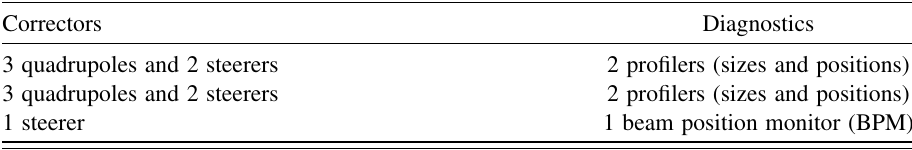
TABLE III. The correction scheme of the MEBT.